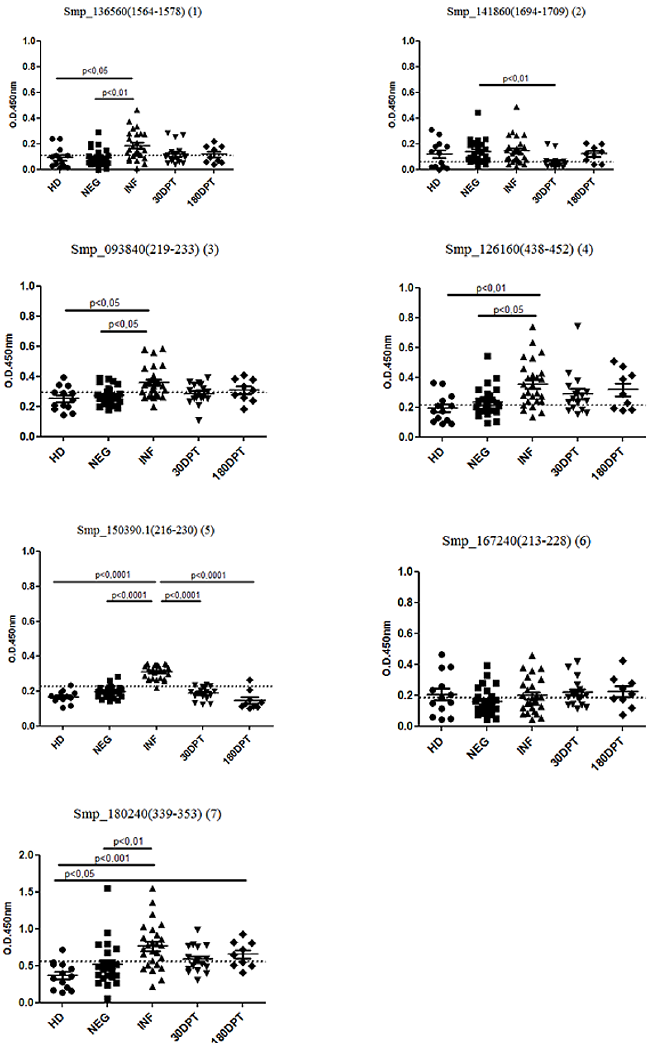
Fig 2. Human IgG-specific response against synthetic peptides from S . mansoni targeted for use in diagnosis. Serum samples were collectedfrom 51 individuals living in an area of low endemicityfor S . mansoni infection. Samplesfrom 25 individuals with negative stool examination (NEG) and from 26 individuals with positive stool examination were evaluated(INF). Sera from patients treated 30 and 180 days after treatment were also evaluated. Additionally,sera from 13 healthydonors (HD) not living in an endemic area for schistosomiasis were used as a negativecontrol. Significant differences betweengroups are indicatedin the graphic. Dashedlines represent the cutoff in the absorbance level which determines specificity and